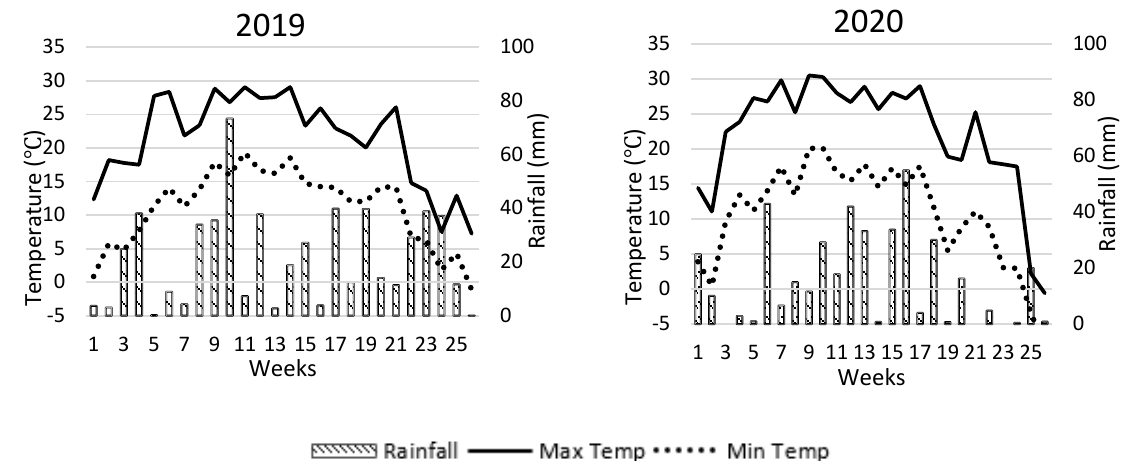
Figure 1. Soybean growing season weekly (week 1 starts at 1 May) mean temperatures after seeding and rainfall totals for 2019 and 2020 Fargo environments.